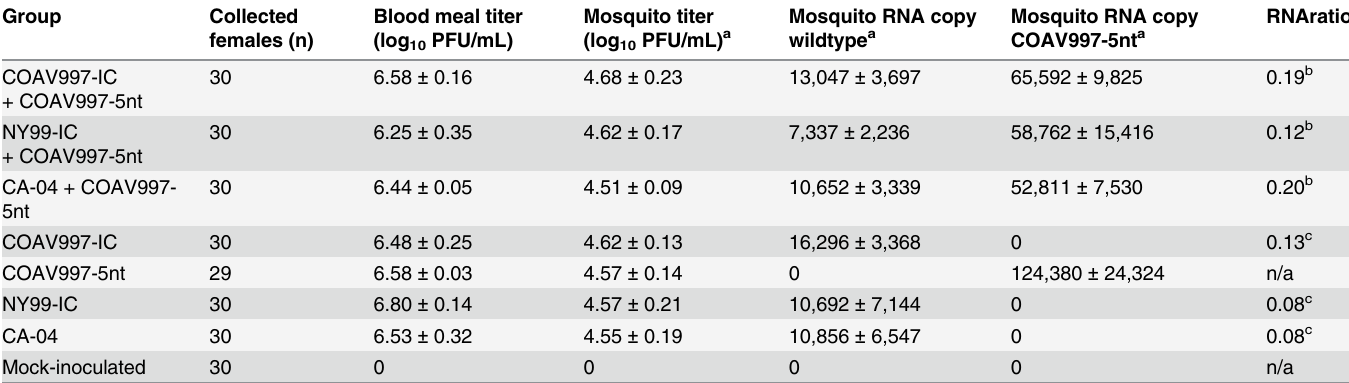
quitoes (Table 2). These titers represent biologically relevant doses typically found during natu- ral WNV transmission between HOFIs and Cx . tarsalis [21]. Analysis by qRT-PCR amplicons Table 2. Viral titer and RNA copy numbers from Culex tarsalis blood meals and relative input ratios between groups. Group Collected females